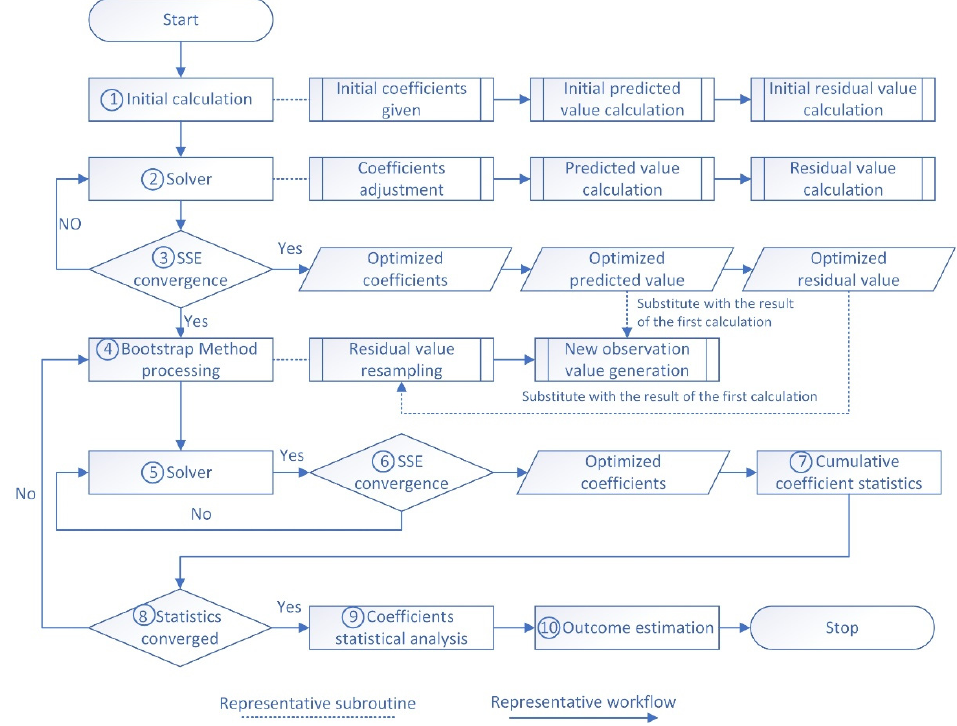
Figure 3. Nonlinear regression workflow. The numbered items are the key steps of the process, detailed in the following text.